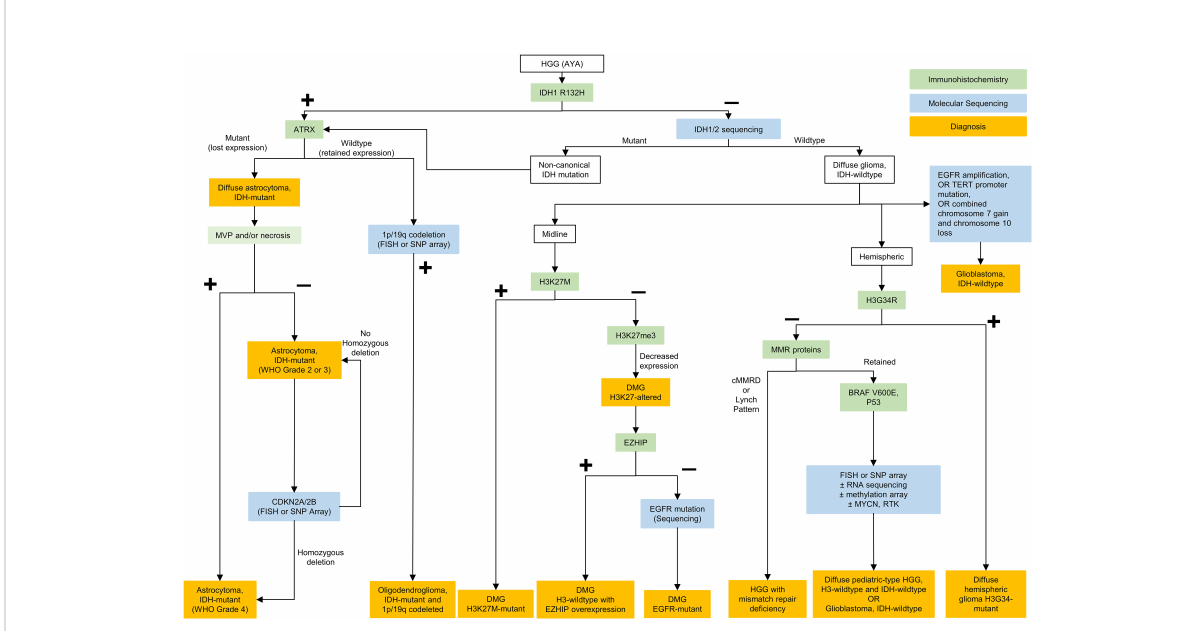
FIGURE 1 Testing algorithm for adolescent and young adult high grade gliomas. HGG, high grade gliomas; AYA, adolescent and young adults; IDH, isocitrate dehydrogenase; ATRX, ATRX chromatin remodeler; CDKN, cyclin-dependent kinase inhibitor; FISH, fl uorescence in situ hybridization; SNP, single nucleotide polymorphism; WHO, World Health Organization; DMG, diffuse midline glioma; EGFR, epidermal growth factor receptor; RNA, ribonucleic acid; EZHIP, EZH Inhibitory Protein; MMR, mismatch repair; cMMRD, constitutional mismatch repair de fi ciency; BRAF, B-Raf; MYCN, N-myc proto oncogene; RTK, receptor tyrosine kinase; NTRK, neurotrophic tyrosine receptor kinase; TERT, telomerase reverse